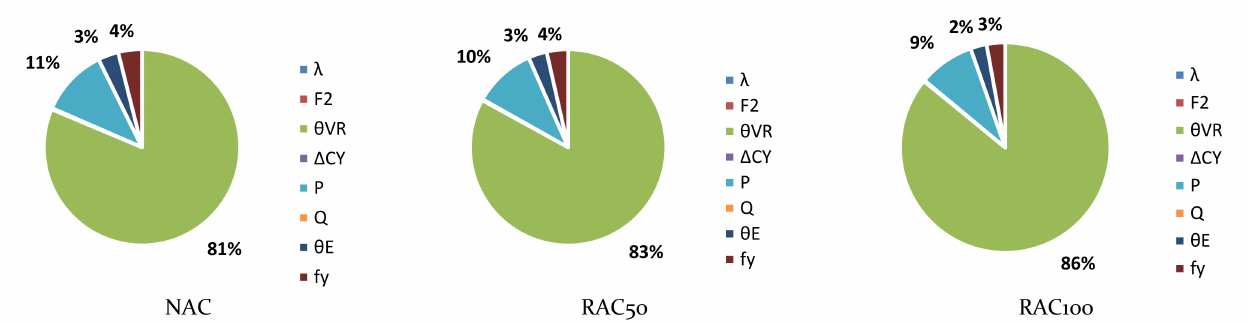
Figure 9. α 2 for χ = 0 and θ R Assumption 1. EN1992 [31] and prEN1992 [32]. γ RAC = 1.0 (not calibrated).